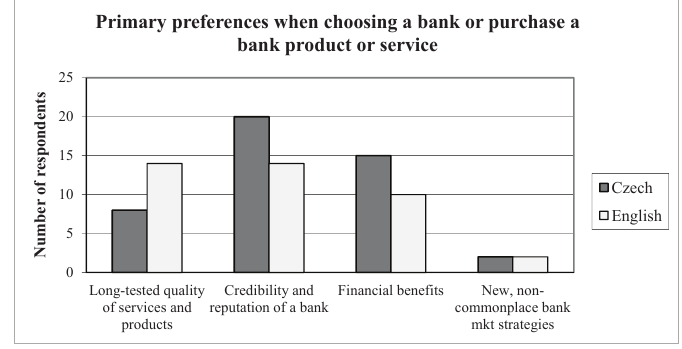
Fig. 3 – Students’ primary preferences when choosing a bank or purchasing a banking product or service. Source: Author´s own.